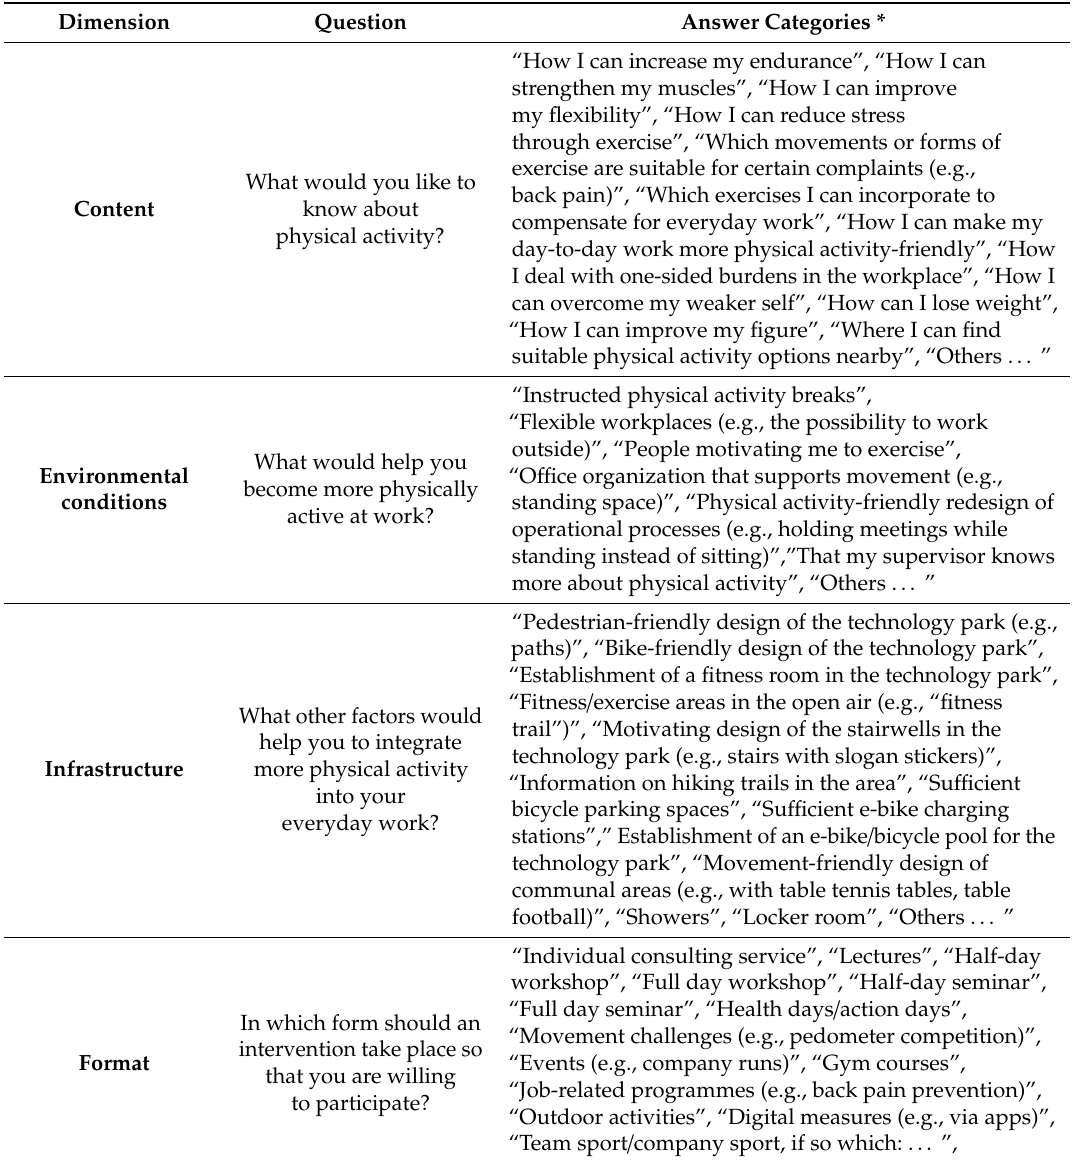
Table 1. Non-standardised questions for assessing the requests in relation to physical activity-related measures